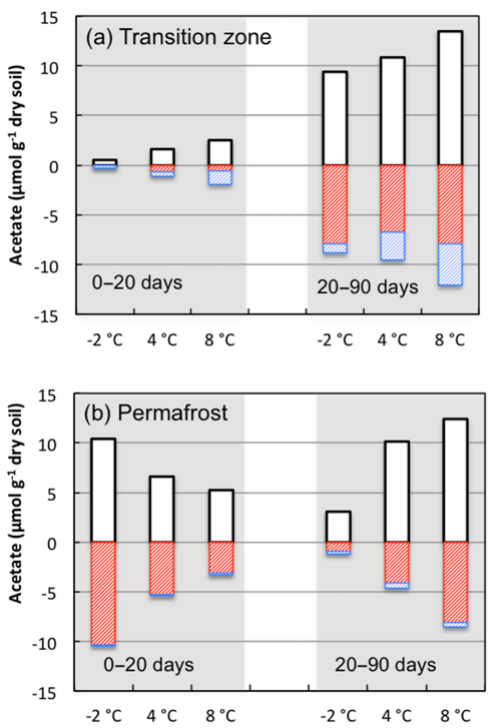
and K m , O ) 4 2 Figure 9. Changes in acetate concentrations associated with pro- duction (white bars) and consumption by iron-reducing bacteria (red bars) or methanogens (blue bars) were estimated using sto- ichiometric calculations based on measurements of methane and Fe(II) during incubations from 0 to 20 days and from 20 to 90 days at the indicated incubation